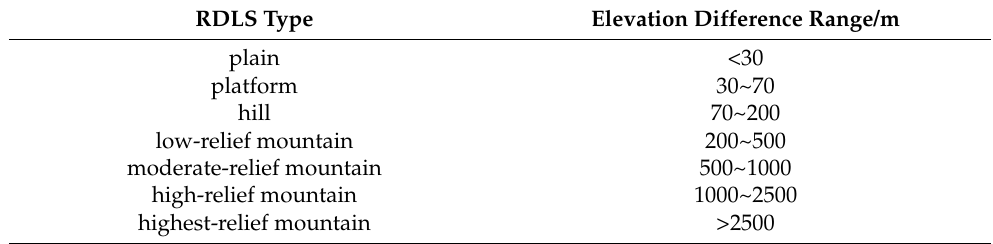
Table 5. RDLS classification.